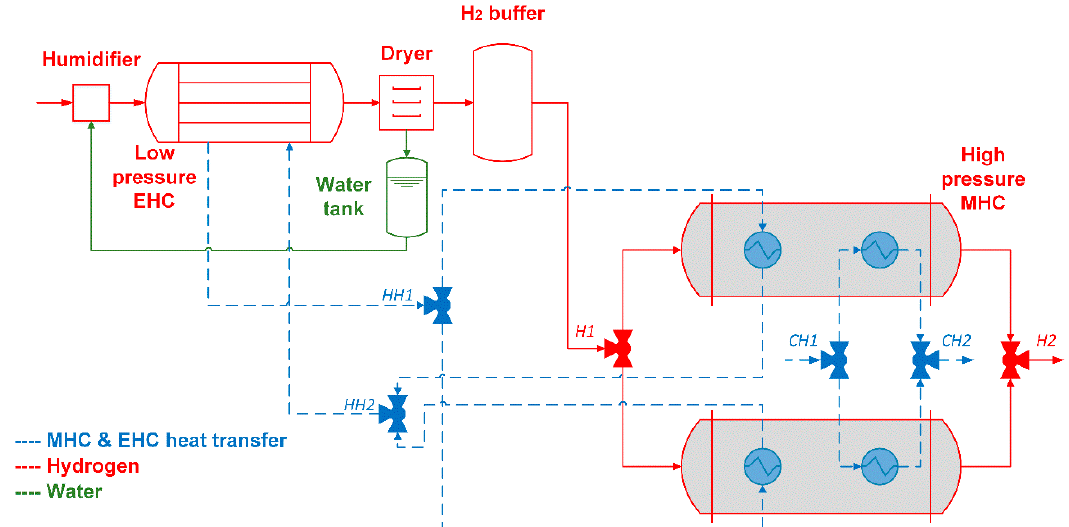
Figure 1. Hybrid electrochemical compressor (EHC) / metal hydride compressor (MHC) system concept. H1 and H2 represent the hydrogen inlet and outlet sections of the metal hydride stage. HH1 and HH2 represent the hot utility fluid inlet and outlet sections of the metal hydride system, respectively. CH1 and CH2 represent the cold utility fluid inlet and outlet sections of the metal hydride system, respectively.